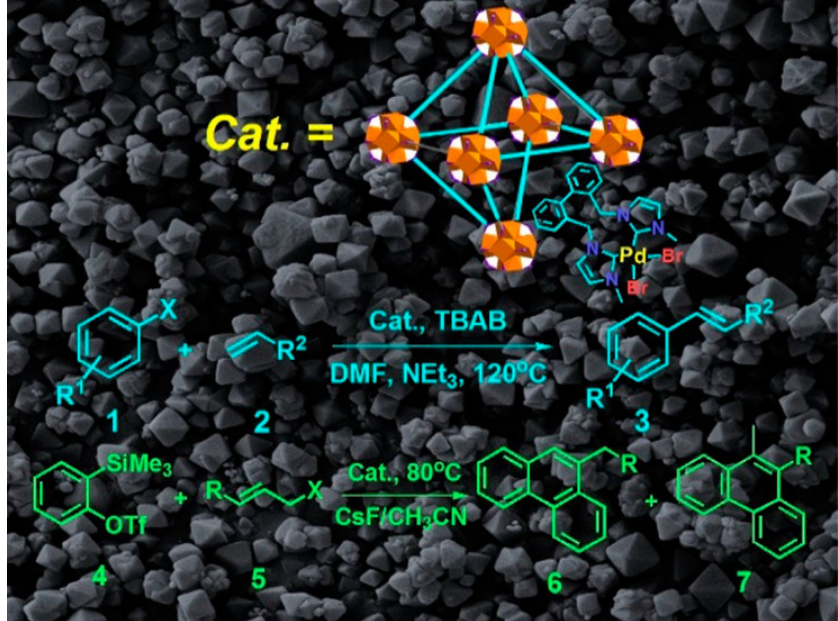
Figure 9. NHC ( N -heterocyclic carbene) ligand bonded Pd sites in MOFs for Heck cross-coupling reaction. Orange = Zr-O clusters. Adapted with permission from [99]; Published by American Chemical Society, 2018.